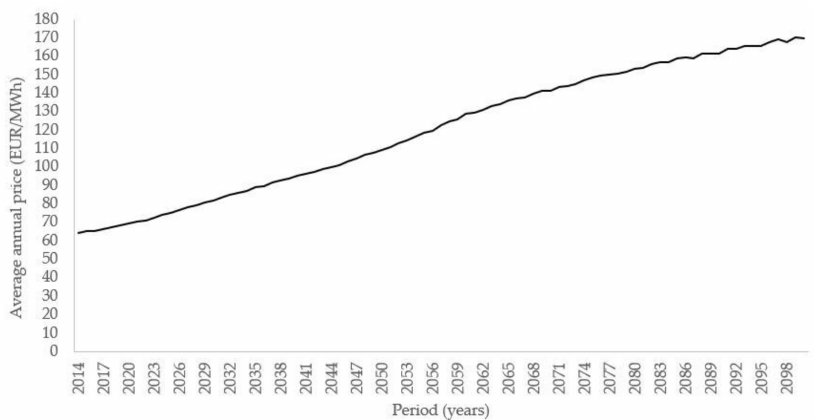
Figure 3. Trend of average annual prices of electricity over the period 2014–2100